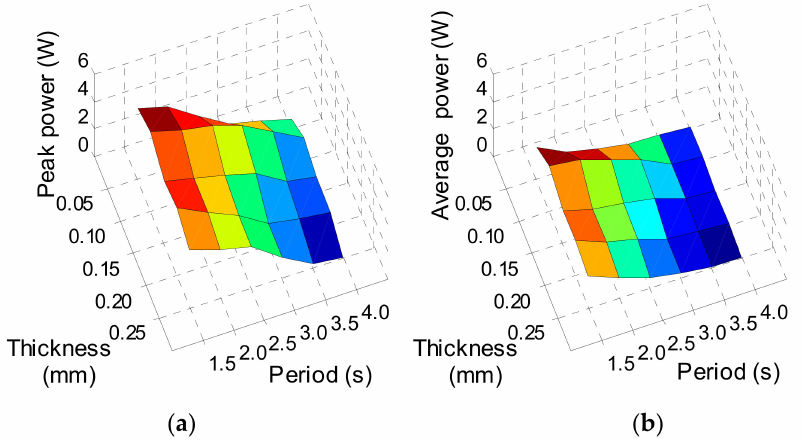
Figure 25. The combined e ff ect of motion period and blade thickness on WEC power characteristics: ( a ) Peak power; ( b ) Average